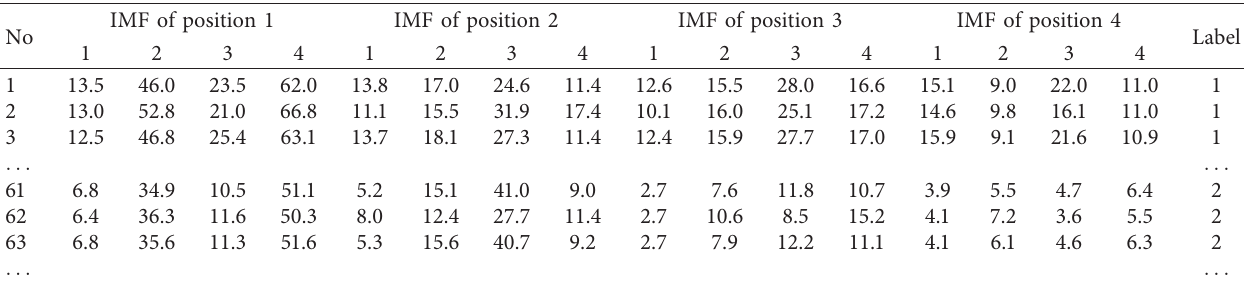
Figure 14: Decomposition result of original signals by MVMD under left 1-cylinder misfire. Table 3: Energy values of 4 IMF components at each measuring point under different